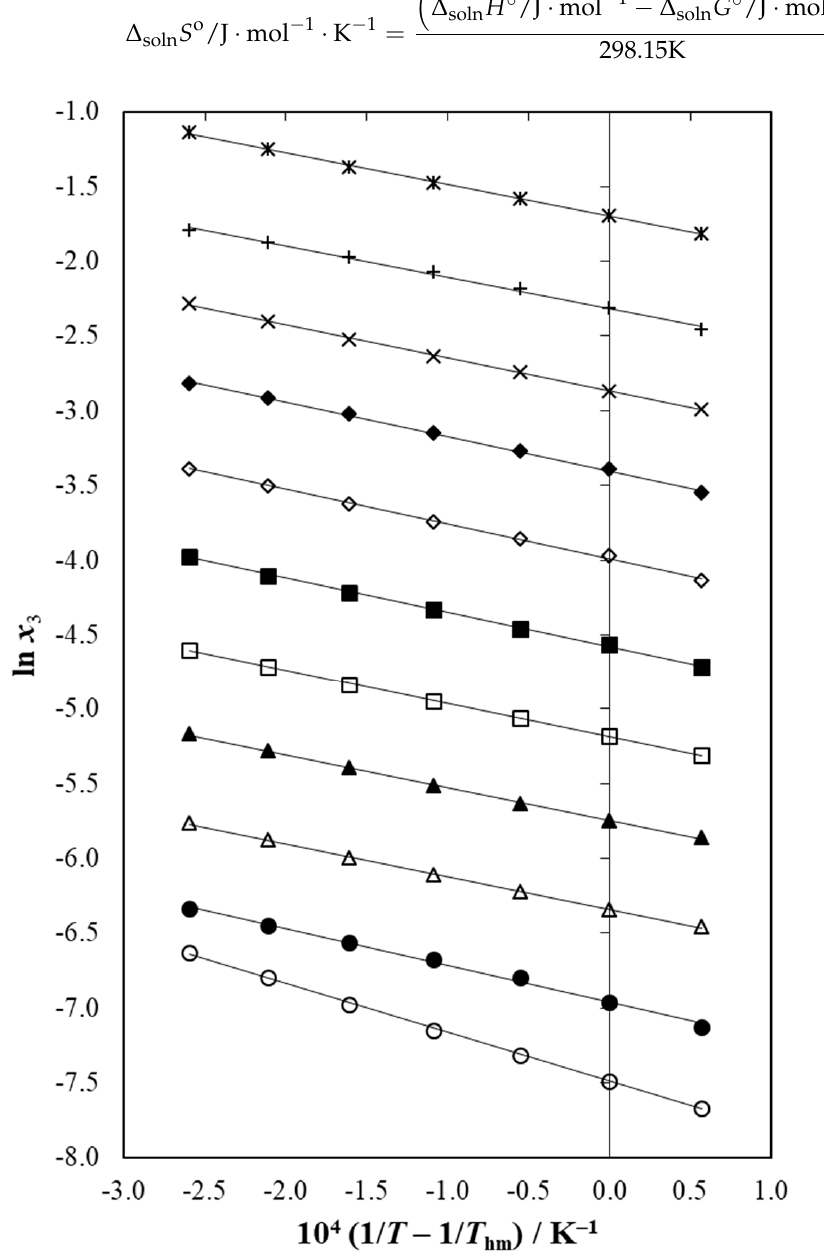
Figure 3. van ’t Hoff plot of the solubility of benzoic acid (3) in some {ethanol (1) + water (2)} solvent systems. ○ : w 1 = 0.00 (neat water), ● : w 1 = 0.10, Δ : w 1 = 0.20, ▲ : w 1 = 0.30, □ : w 1 = 0.40, ■ : w 1 = 0.50, ◊ : Table 5 summarizes the standard apparent molar thermodynamic functions for disso- lution processes of benzoic acid (3) in neat solvents and in all the {ethanol (1) + water (2)} mixtures at T = 298.15